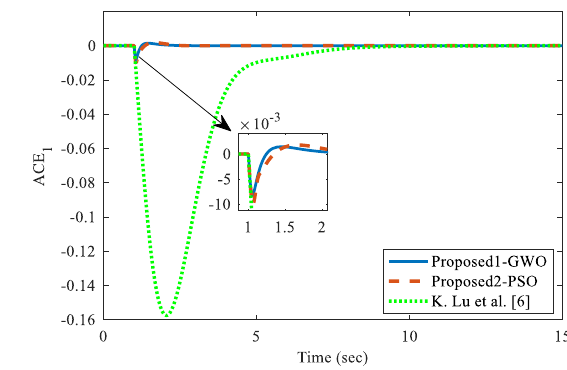
Fig. 14 Frequency regulation in area 2 for case 5b